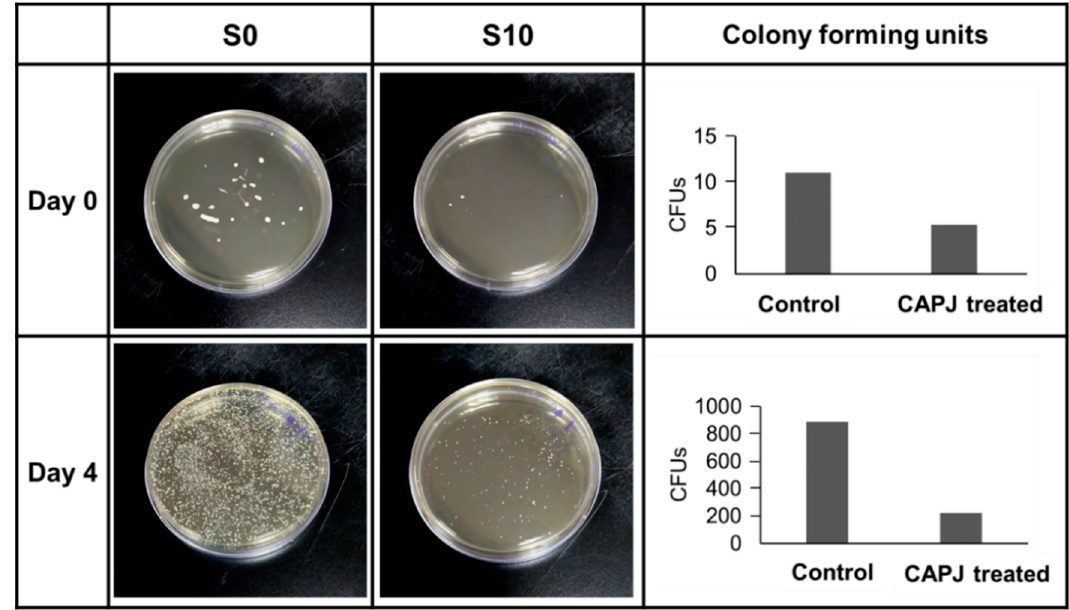
Figure 9. S10 CAPJ reduces bacterial infection in the wound. Rat wound was untreated or treated with S10 CAPJ, and the bacterial loads in the wound were counted on days 0 and 4. Viable bacteria were represented as colony forming units (CFUs).